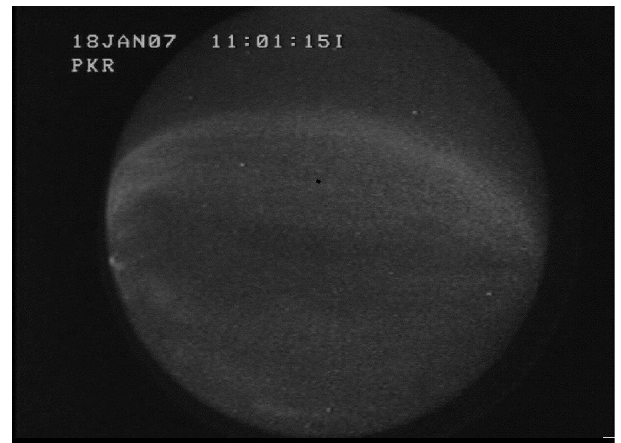
Fig. 12. The medium field camera image, from 18 January 2007, showing the black aurora patches in the magnetic zenith, which is indicated by the black box near the center of the image. North is up and east is to the left.